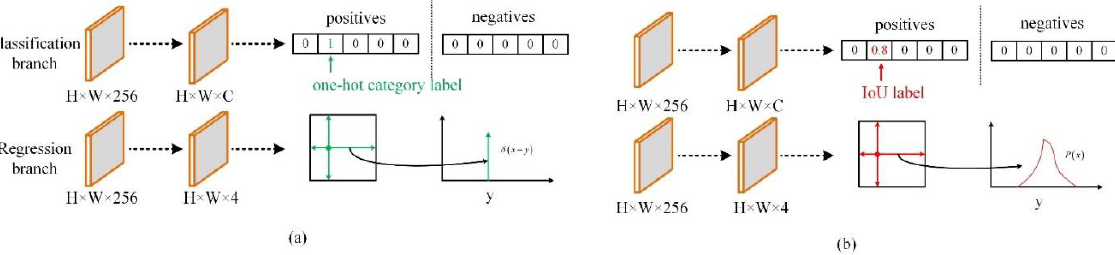
Figure 5. Schematic diagram of different detection heads. ( a ) FCOS + ATSS. ( b ) The proposed